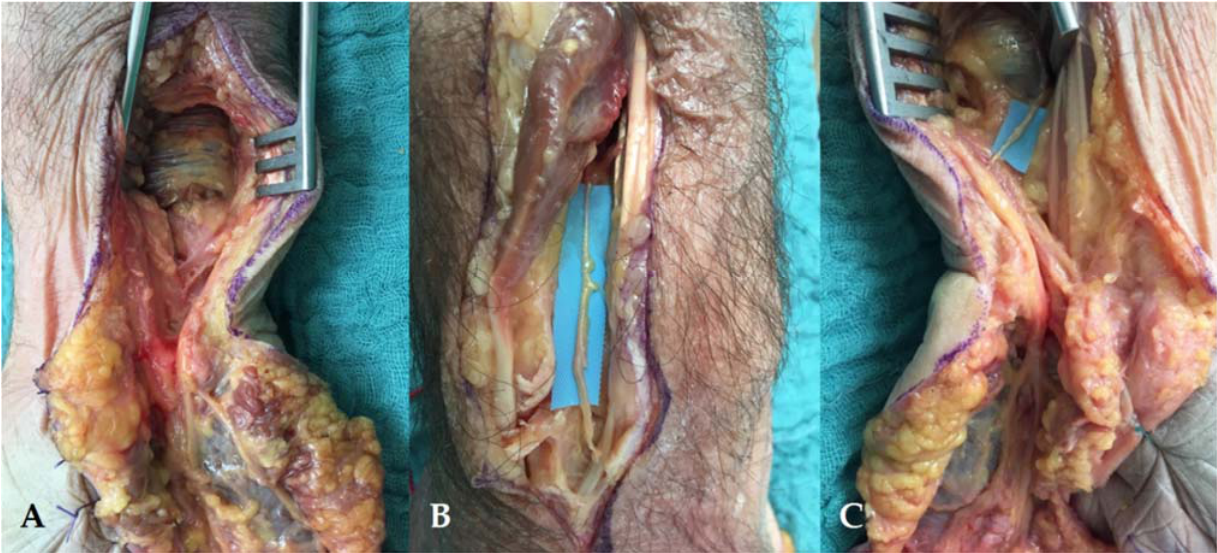
Figure 9. ( A ) Exposure of the pronator quadratus. The pronator quadratus was identified and an incision was made to expose the interosseous membrane. ( B ) Dorsal approach of the DRUJ. The PIN was released over 5.5 cm and transected distally. ( C ) Retrieving the PIN at the palmar side of the forearm. The PIN was passed through the interosseous membrane in order to make the ETE suture with the sensory fascicle of the SBUN.